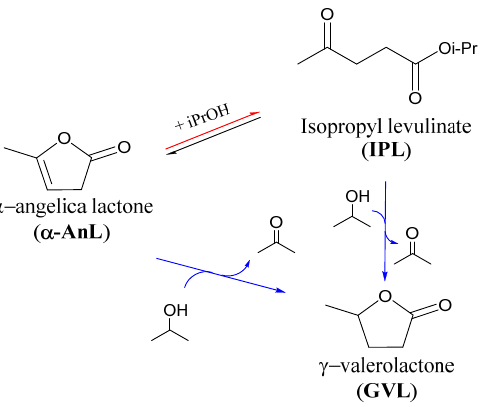
Figure 12. Simplified scheme of angelica lactone transformation in GVL and IPL. Blue arrows indicate the need for Lewis acidity while red arrows indicate the need for Brønsted acidity.